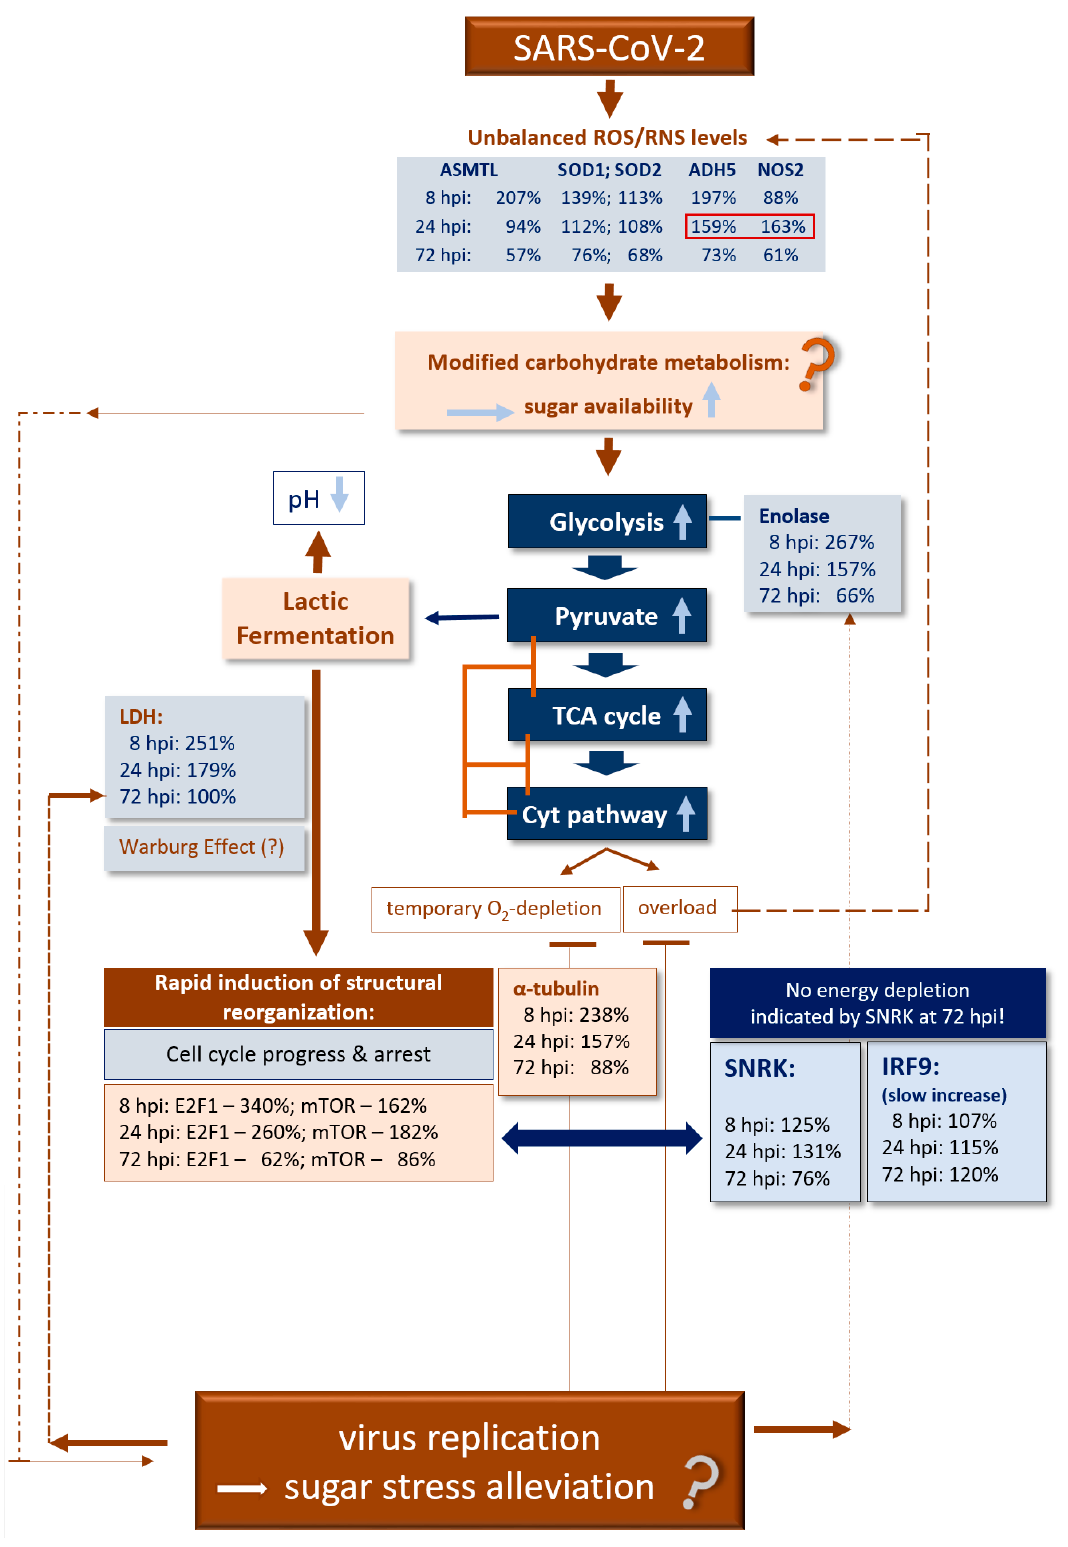
Figure 4. Validating CoV-MAC-TED as a crucial trait for early SARS-CoV-2-induced reprogramming in human nasal epithelial cells—a simplified scheme for hypothetical metabolic principles and validation of markers.